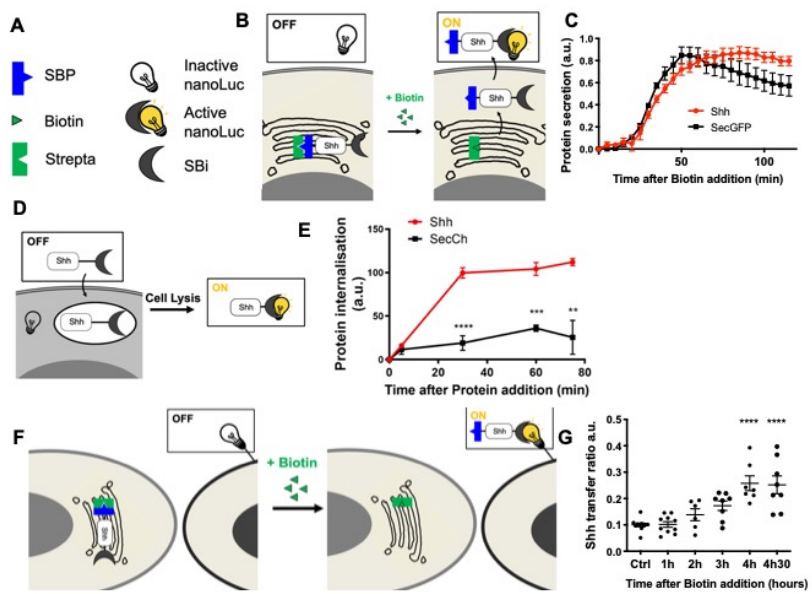
Figure 2. Quantitative monitoring of the journey of Shh in HeLa cells. ( A – C ) Quantifying Shh secretion by HeLa cells. ( A , B ) Schematic representation of the tools ( A ) and assay ( B ). ( A ) Strepta: core streptavidin linked to the KDEL hook; SBP: streptavidin-binding peptide linked to Shh or a secreted form of GFP (secGFP); SBi: small fragment of split nanoluciferase (HiBiT) linked to Shh or secGFP; inactive nanoLuc: large fragment of split nanoluciferase (LgBiT); active nanoLuc: reconstituted nanoluciferase. ( B ) Synchronized HeLa cells constitutively express the hook, and they express Shh fused to SBP and HiBiT (Shh-SBP-HiBiT) under doxycycline control. Purified LgBit added to the medium binds HiBiT when Shh reaches the extracellular space, and nanoLuc activity gives a measure of secretion. ( C ) Time course of Shh synchronized secretion compared to the control (secGFP fused to SBP and HiBiT). ( D , E ) Quantitating Shh internalization by HeLa cells. ( D ) Schematic representation of the assay. Shh fused to HiBiT (Shh-HiBiT), purified from the conditioned medium of producing HeLa cells and calibrated in vitro, was added to HeLa cells expressing inactive nanoLuc (LgBiT) in the cytosol. Upon cell lysis, nanoluciferase is reconstituted from endocytosed Shh-HiBiT and cytoplasmic LgBiT, allowing quantification of internalization. ( E ) Time course of Shh internalization compared to the control (a secreted form of mCherry: secCherry, fused to HiBiT and prepared in parallel to Shh). ( F , G ) Quantitating Shh delivery to recipient HeLa cells. ( F ) Schematic representation of the assay. Two HeLa cell populations are co-cultured. In the first one, synchronization of Shh release is achieved as in the secretion assay but for a longer period of time. The second population expresses inactive nanoLuc (LgBiT) at the cell surface (anchored via the CD4 transmembrane domain). Active nanoluciferase is reconstituted by the transport of tagged Shh (Shh-SBP-HiBiT) from a donor cell to the surface of a receiving cell. ( G ) Time-course analysis of Shh delivery to recipient cells becomes strongly significant approximately 3 h after biotin addition. Ctrl: without biotin. ** p -value ≤ 0.01; *** p -value ≤ 0.001; and **** p -value ≤ 0.0001. Details on statistics in